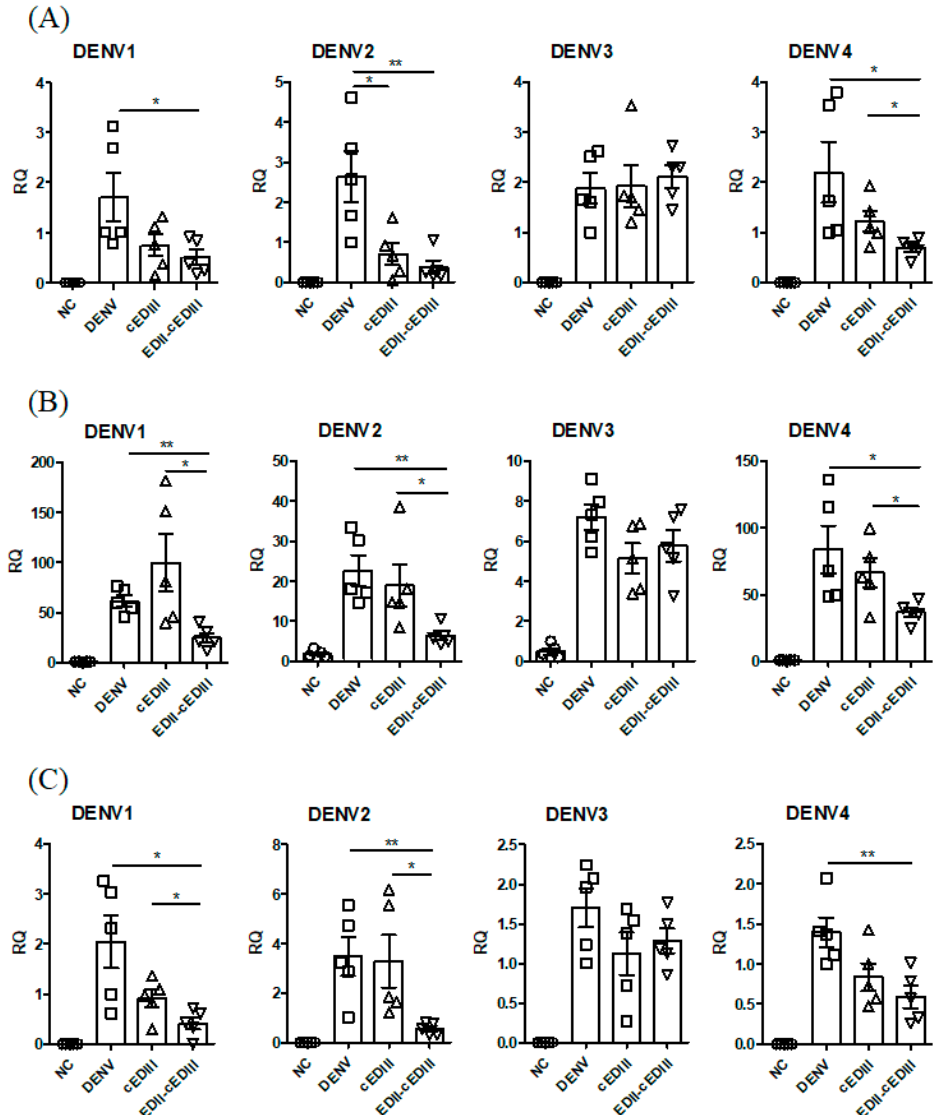
Figure 7. DENV infection at secondary sites is inhibited by purified Abs. Liver tissues collected 5 days after DENV infection with or without the indicated Ab were subjected to RT-qPCR analysis of the levels of ( A ) viral RNA and ( B ) interferon (IFN)- γ . ( C ) Virus in the small intestine was quantified by RT-qPCR at day 5 post-infection. A representative result from two or three independent experiments is shown. Unpaired two-tailed t -test. * p < 0.05 and ** p < 0.01 indicate significant differences. Squares, triangles, and inverted triangles represent the results from DENV-, anti-cEDIII Ab, and anti-EDII-cEDIII Ab-treated groups, respectively.